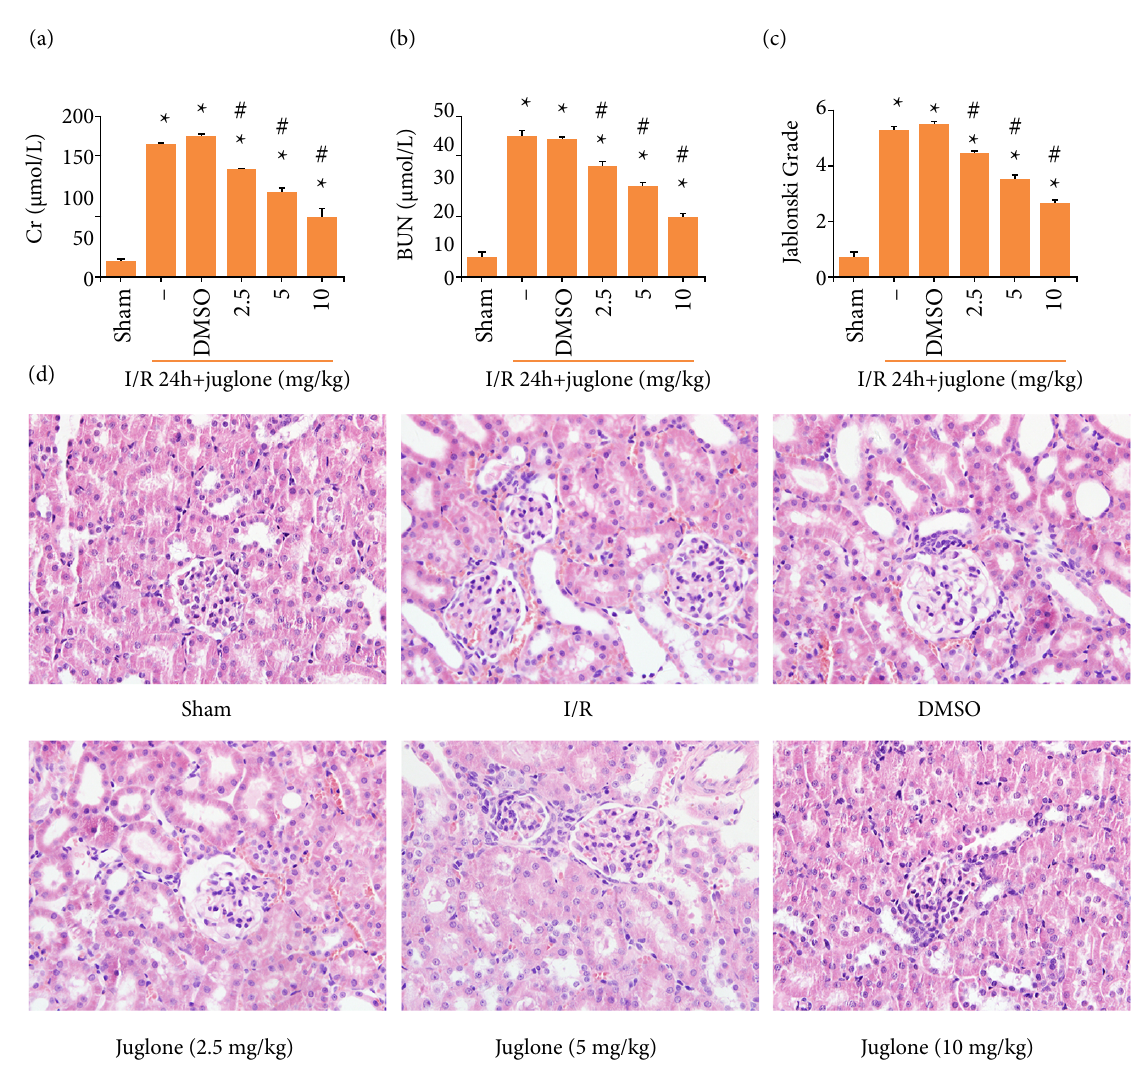
Figure 2 - Pin1 inhibitor protected kidney against I/R injury in rats. (a, b) The effect of Juglone at different concentration (2.5, 5 and 10 mg∙kg –1 ) on renal function in rats subjected to ischemia 45 min and reperfusion 24 h. (c) The effect of Juglone at different concentration (2.5, 5 and 10 mg∙kg –1 ) on renal structure damage detected by H&E staining (400×). Values were expressed as the mean ± SEM (n = 8). *P < 0.05, relative to Sham group; #P < 0.05, relative to I/R group. Pin1 suppression attenuated Nrf2/HO-1 pathway and endoplasmic reticulum stress mediated by I/R Western-blot demonstrated that Pin1 expression were inhibited by its inhibitor at the concentration of 10 mg∙kg –1 (Fig. 3a). Then, the correlation of Pin1, Nrf2/HO-1 and ER stress was determined during I/R. As shown in the Fig. 3b and c, Pin1 inhibitor significantly rescued the down-regulation of Nrf2/HO-1 in the presence of I/R. In addition, ER stress- associated protein levels, including GRP78, p-eIF2 α / eIF2 α and CHOP, were elevated in I/R-injured kidney, and juglone treatment prevented I/R-mediated up-regulated ER stress-associated protein levels (Fig. 3d–f). Taken together, Pin1 inhibition prevented Nrf2/HO-1 down-regulating and restricted ER stress in the context of